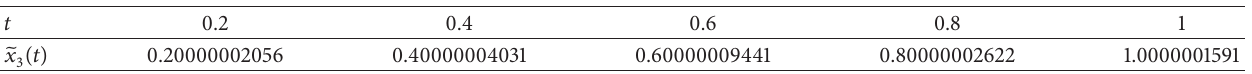
Table 1: Some numerical values of the solution ̃𝑥 3 (𝑡) of (53) with 𝑁 = 3 , very close to the values of the solution 𝑥(𝑡) = 𝑡 of the fractional differential equation of variable order